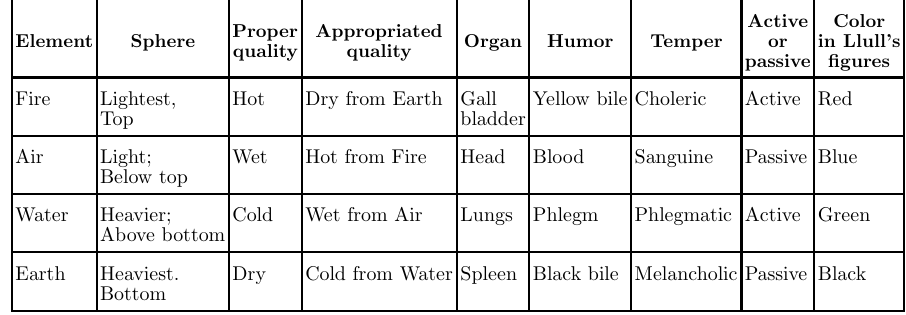
Figure 8. The four elements and their correlates in Llull’s